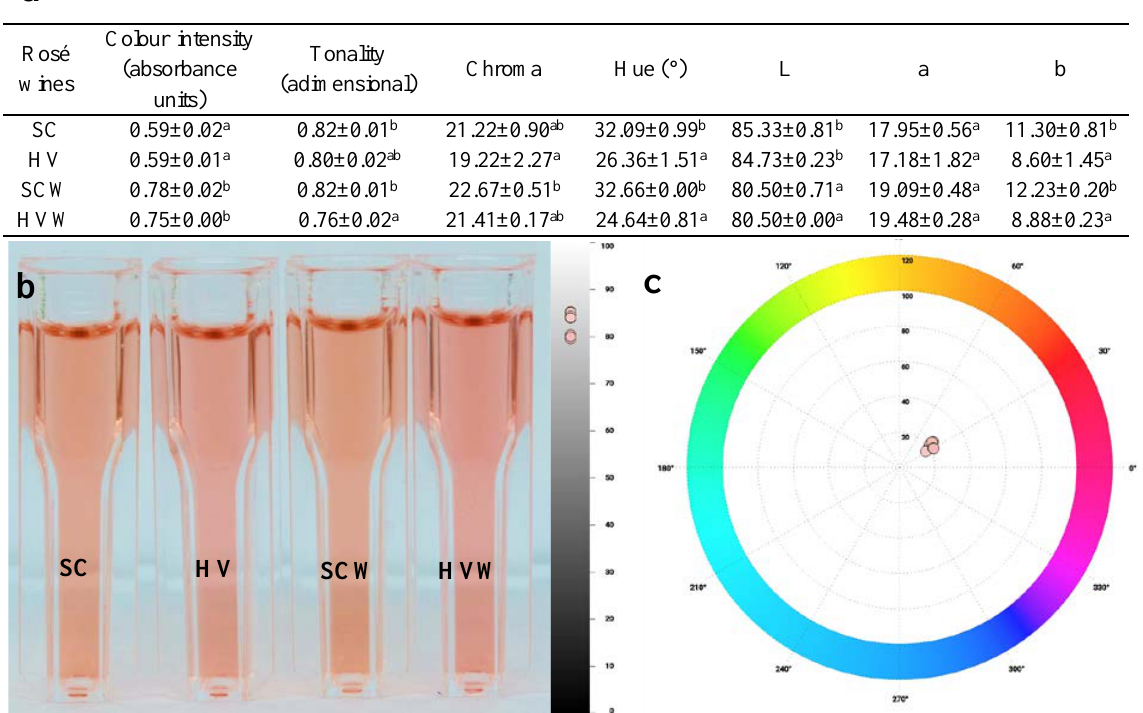
Figure 1. Colour parameter values and CIELab coordinates ( a ); visual colour aspect of rosé wines ( b ); graphic presentation of CIELab coordinates ( c ). SC (fermentations with S. cerevisiae in stainless steel barrels); HV (fermentations with H. vineae in stainless steel barrels); SCW (fermentations with S. cerevisiae in oak barrels); HVW (fermentations with H. vineae in oak barrels). Values in the same column with the same letter are not significantly different ( p < 0.05).